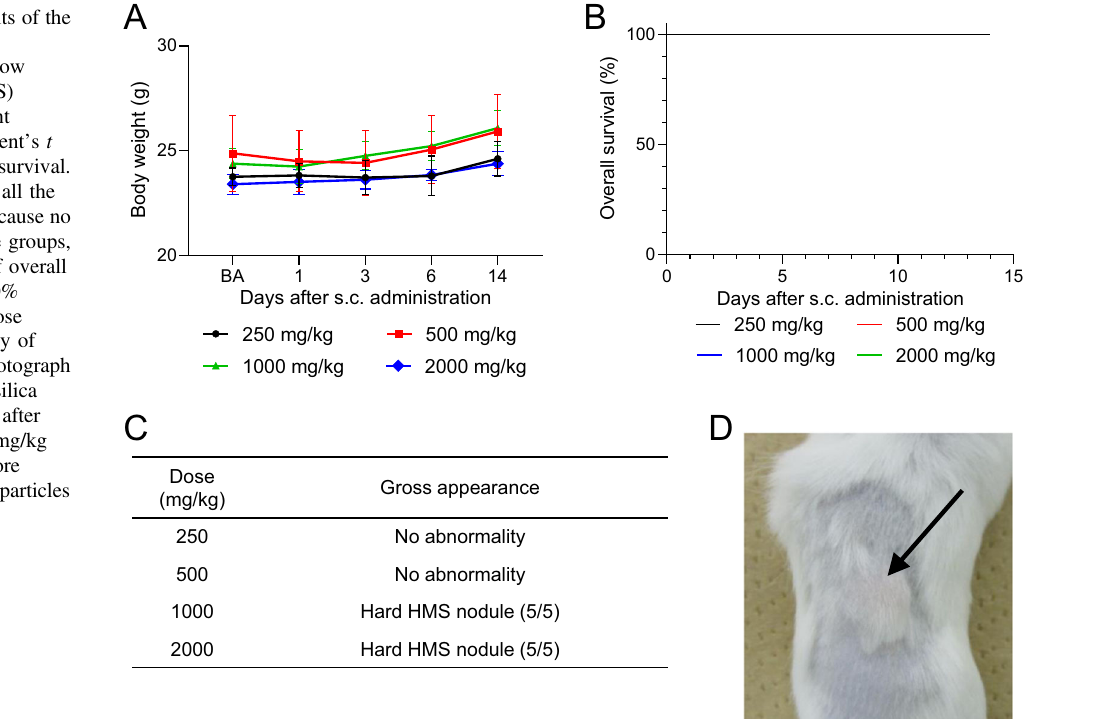
Fig. 2 Observation results of the mice after subcutaneous administration with hollow mesoporous silica (HMS) particles. A Body weight changes. * p < 0.05 Student ’ s